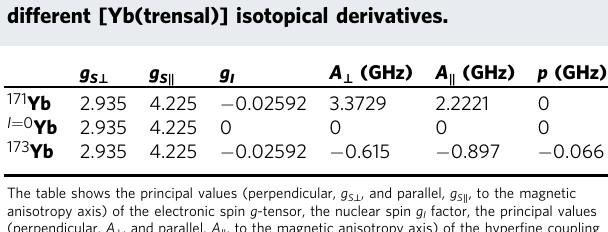
Coupling of spins to a transmission line . The broadband spectroscopy experi- ments were analysed using an input-output theory for a 1 D coplanar transmission line adapted to the conditions of our experiments. In this model, the coupling Γ i , j of a particular spin transition with resonance frequency ( Ω i , j ) to the photons with frequency f traveling through the transmission line is given by: